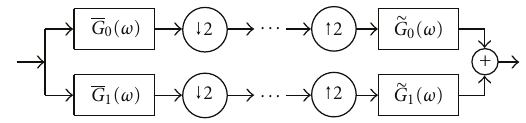
Figure 1: Filter bank structure of primal biorthogonal wavelet.